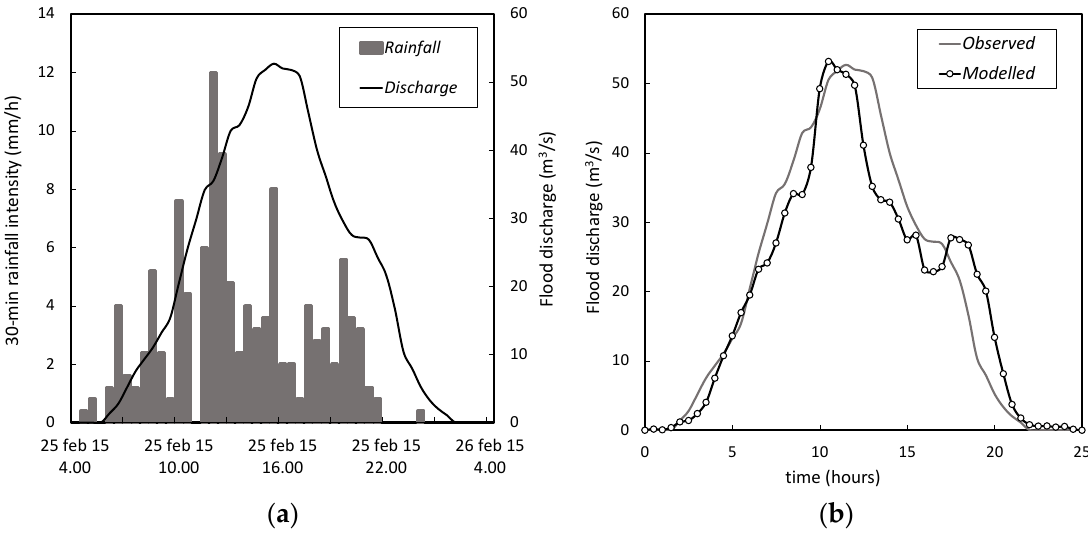
Figure 10. Flood event of 25–26 February 2015: ( a ) Observed flood hydrograph and rainfall; ( b ) comparison between observed and modelled hydrographs.